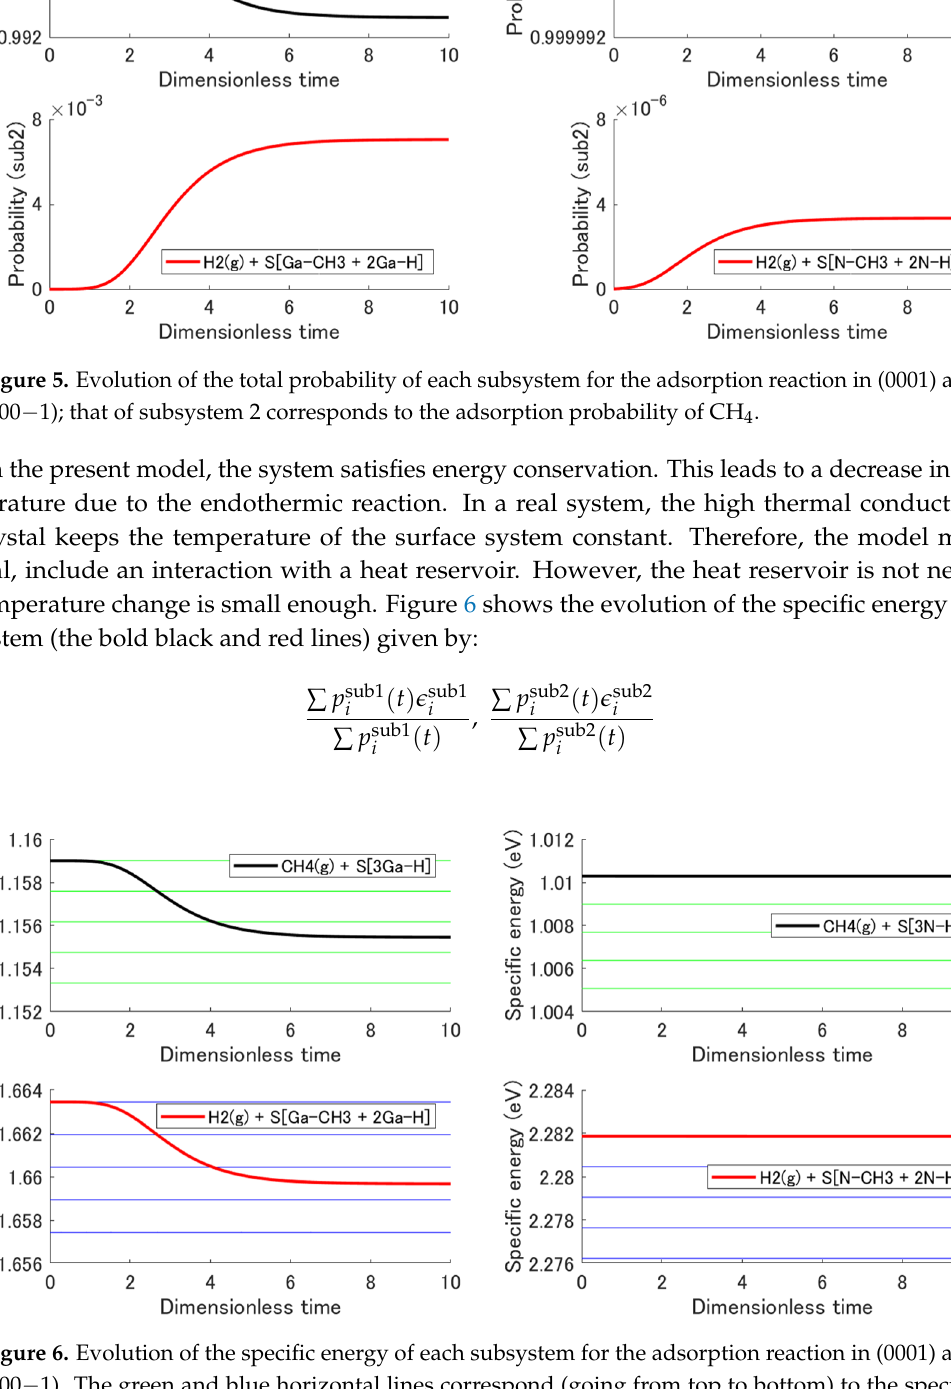
Figure 6. Evolution of the specific energy of each subsystem for the adsorption reaction in (0001) and (000 − 1). The green and blue horizontal lines correspond (going from top to bottom) to the specific energies at 1000, 999, 998, 997, and 996 ◦